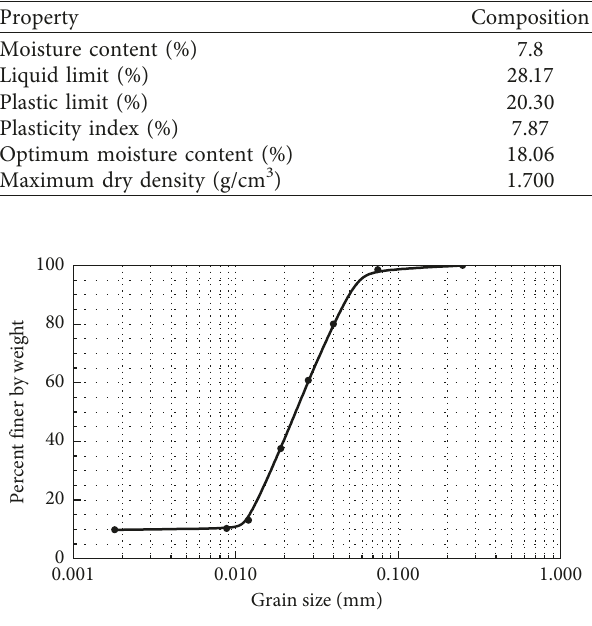
Figure 1: Grain size distribution of the loess. Table 2: Mixture types and number of cylindrical